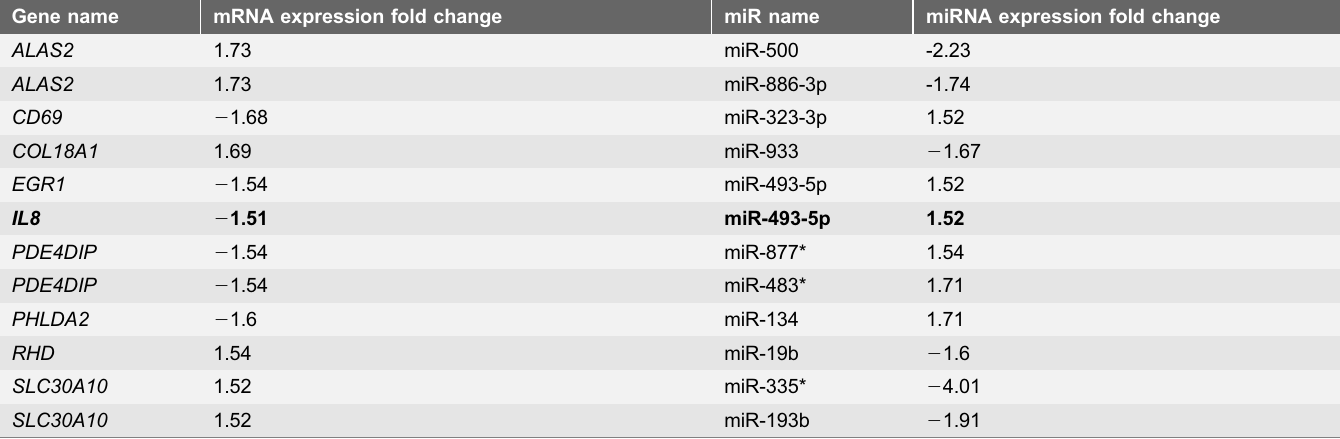
Table 1. 12 predicted imatinib response gene-miRNA pairs based on GEO data.